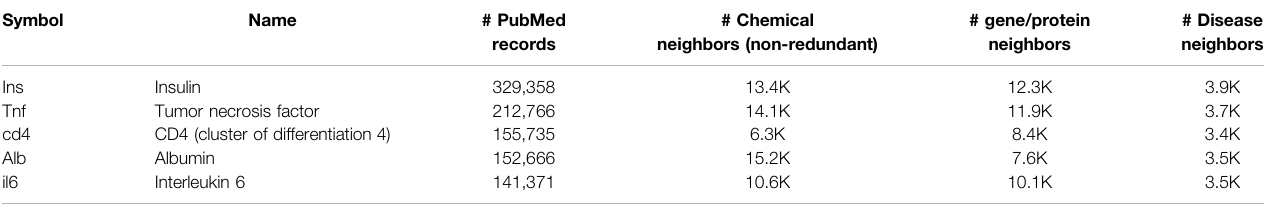
TABLE 4 | Top fi ve most mentioned genes/proteins in PubMed records and the number of their chemical, gene/protein, and disease neighbors. Symbol